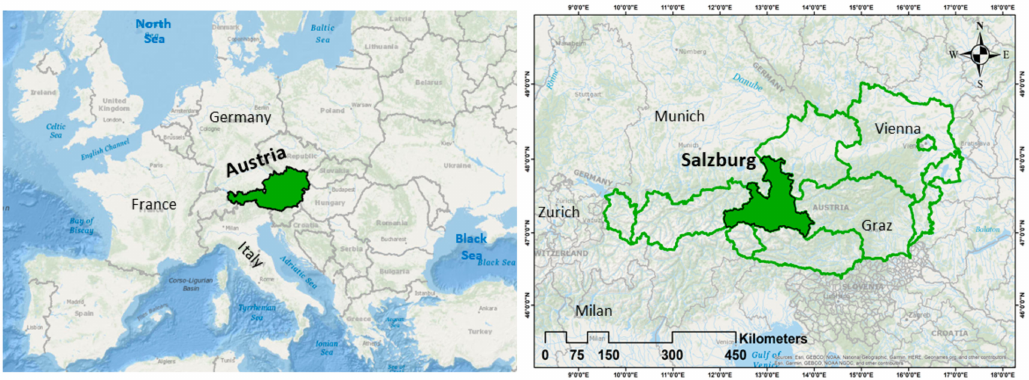
Figure 1. Location of the State of Salzburg,